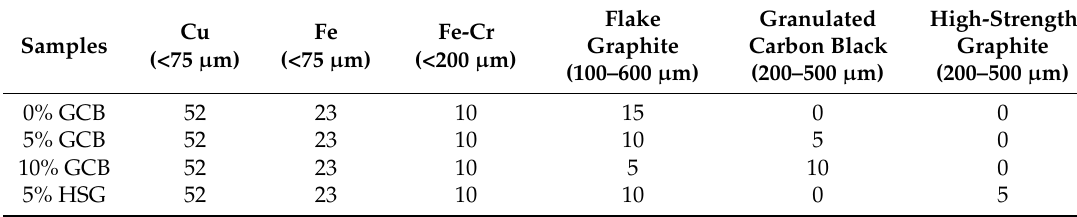
Table 1. Compositions of Cu–Fe based friction materials